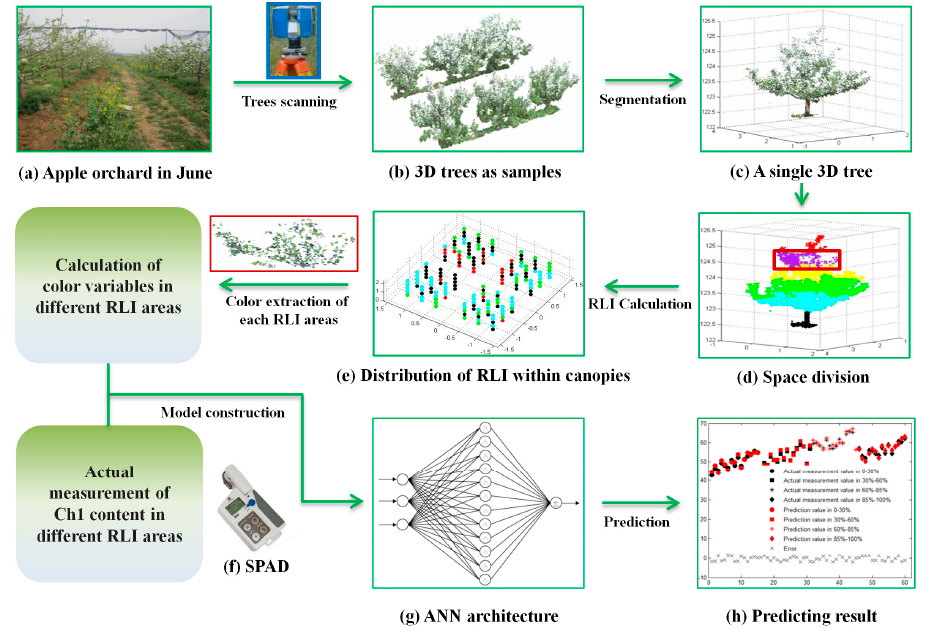
Figure 1. Preprocessing Framework. ANN: artificial neural network; Ch1: chlorophyll; RLI: relative light